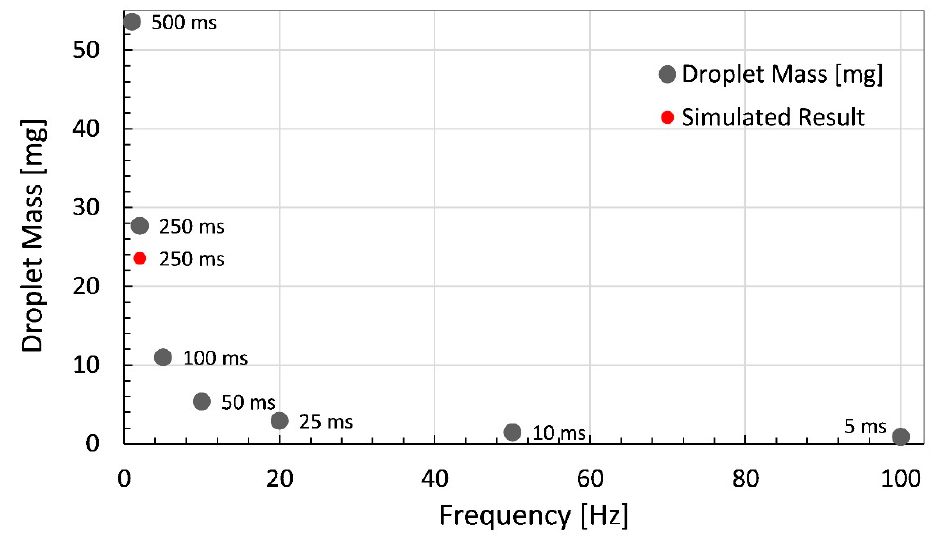
Figure 12. Droplet mass of dispensed droplets plotted against the frequency with respect to appropriate open time in addition to simulation result at 2 Hz frequency and 260 ms open time.